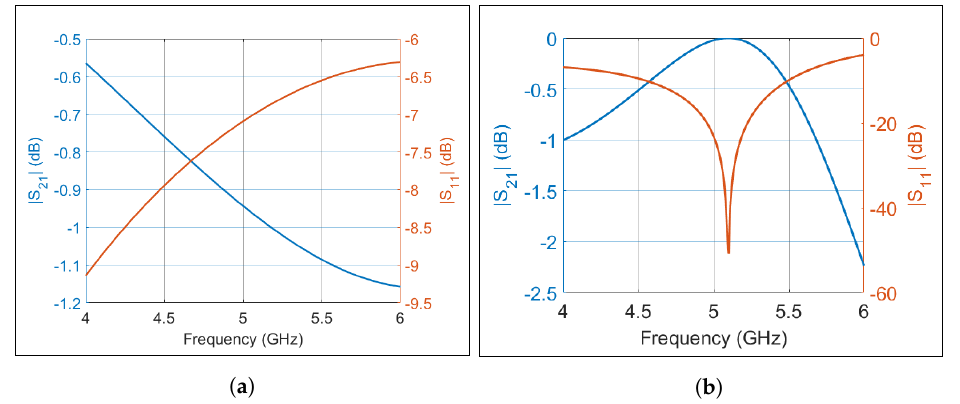
Figure 20. S-parameters for a 10-layer structure consisting alternating MNG ( µ r = − 2.0) and ENG ( (cid:101) r = − 2.0) layers. ( a ) Thickness of each layer, including the plasma layer, is 3.0 mm, approximately 0.072 of the wavelength in each layer. ( b ) Thickness of each layer is increased to 5.23 mm, approximately 0.126 of the wavelength in each layer, to align the bandpass response with the 5.1 GHz operating